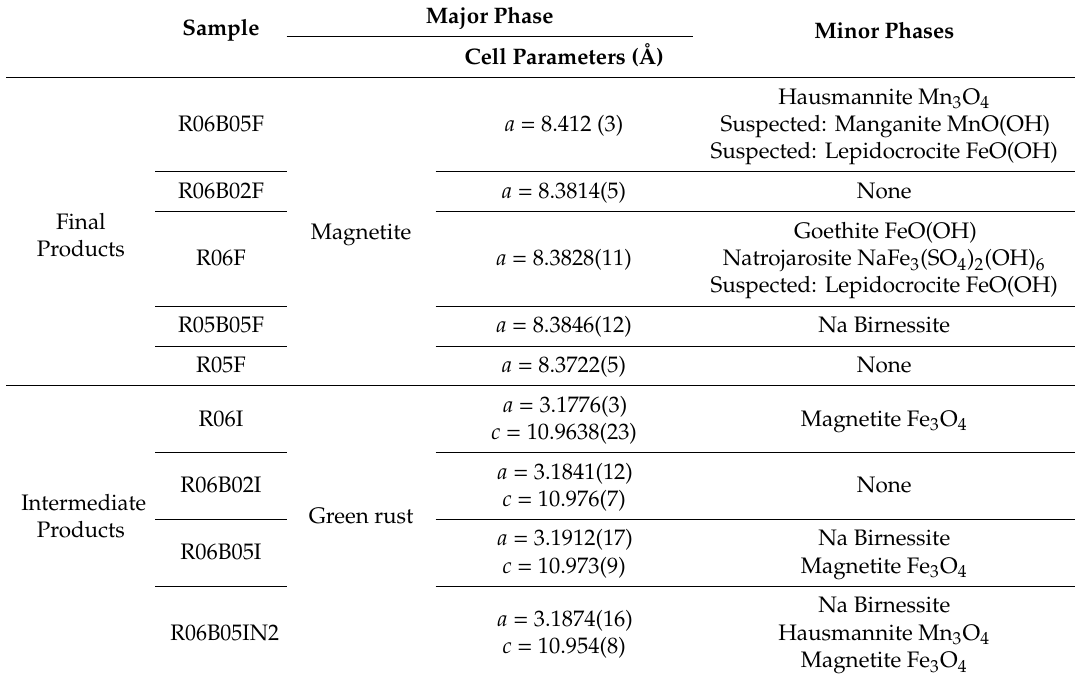
Table 1. Major and minor solid compounds identified by XRD during the oxidation process of Fe(II) species either in the absence or in the presence of